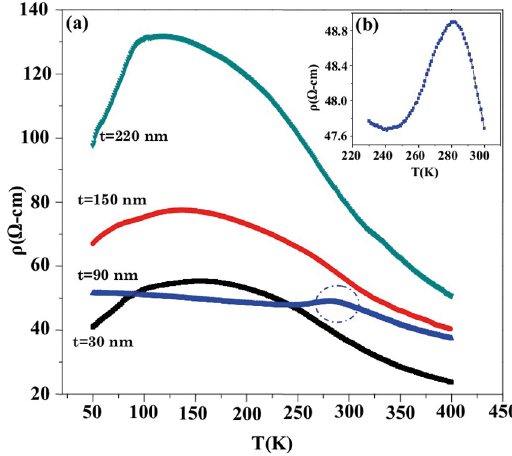
Figure 4. Resistivity versus temperature ρ(T) curves of different thicknesses of CrN/Si (100)films.